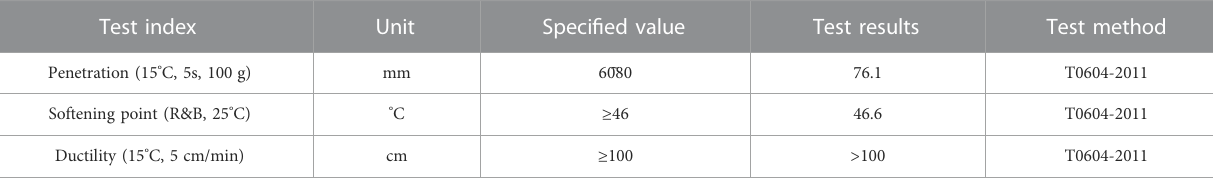
TABLE 3 Technical indexes of 70 # Class A road Petroleum